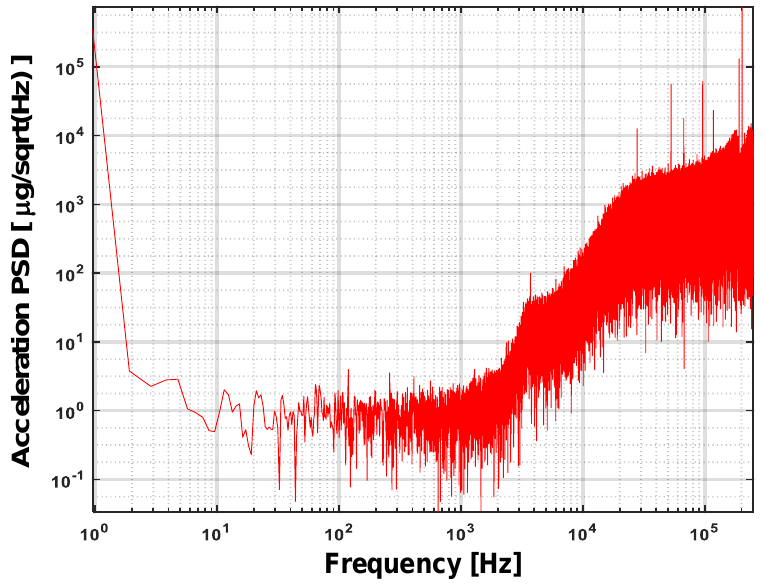
Figure 18. The input referred noise spectrum density of the proposed EM- Σ∆